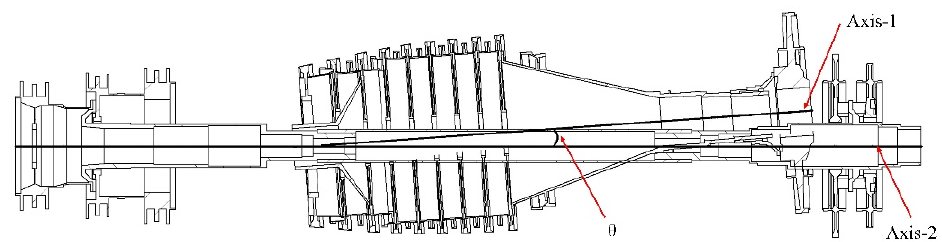
Figure 11. Front deflection angle non-concentricity of dual-rotor.